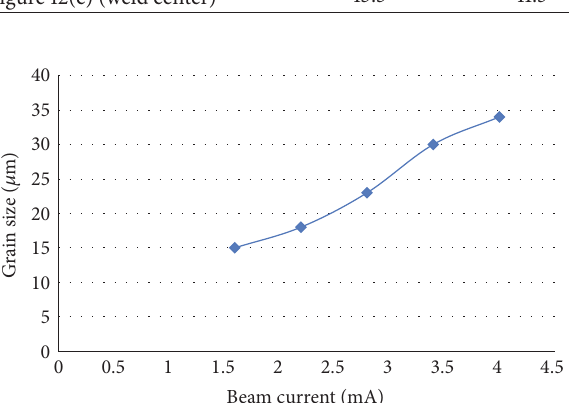
Figure 12(c) (weld center)